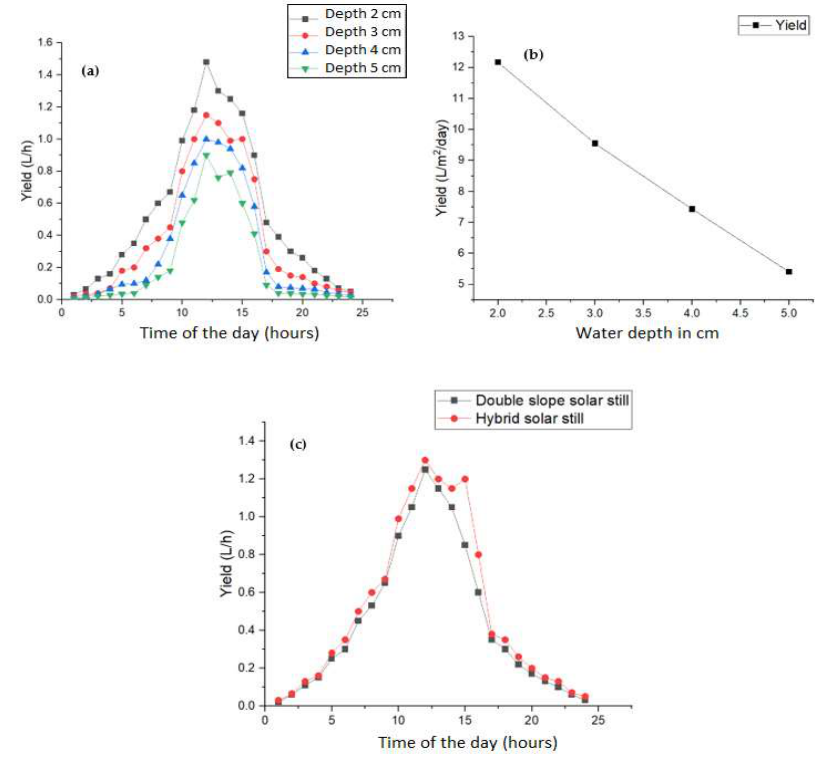
Figure 12. ( a ) Hourly yield for different water depths, ( b ) evolution of the yield of still for different water depths and ( c ) hourly yield of double-slope solar still and proposed hybrid solar still.